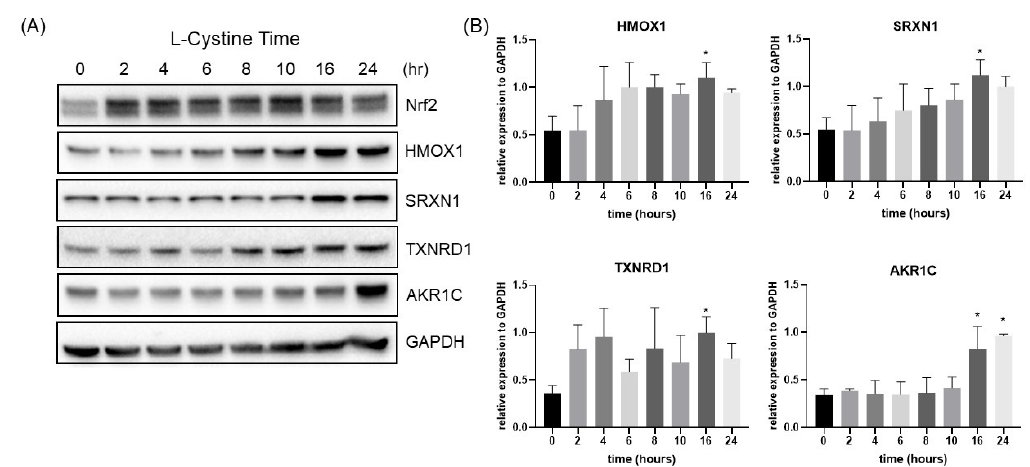
Figure 8. Time-Dependent Elevation of Nrf2 Downstream Genes at the Protein Level. HeLa cells were treated with 0.8 mM L-Cystine and harvested at indicated time points to measure the levels of the proteins by Western Blot, using GAPDH as a loading control ( A ). Quantification of band intensities by NIH ImageJ was shown as means ± SD from three independent experiments ( B ). * indicates statistically significant compared to the 0 h as the adjusted p value < 0.05 by one-way ANOVA, corrected by Dunnett’s multiple comparisons test ( B ).